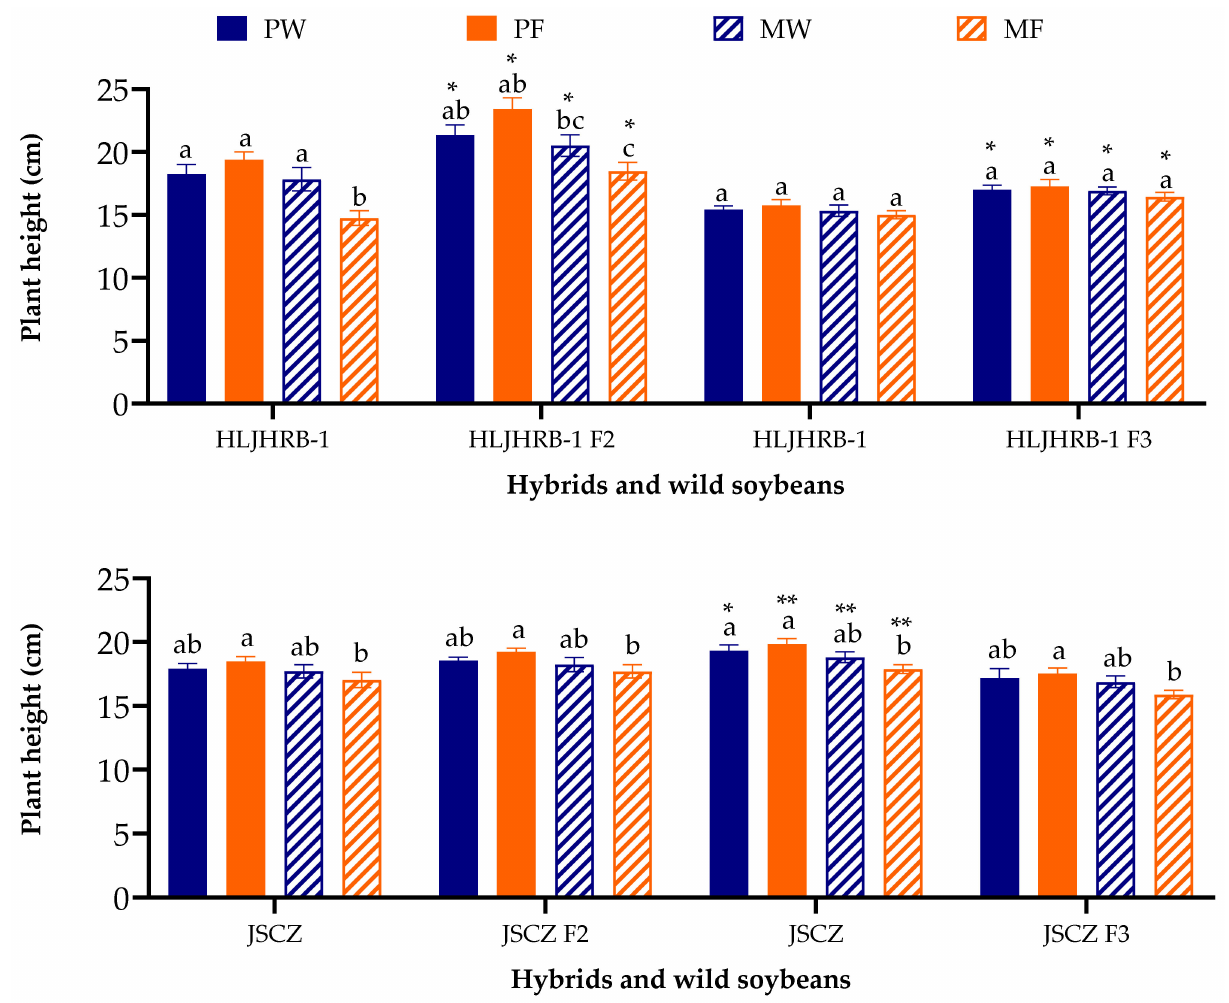
Figure 3. Plant height of hybrids and wild soybean under four planting conditions (the third trifo- liolate leaf stage). Note: * and ** indicate significant difference ( p < 0.05) and extremely significant difference ( p < 0.01) between hybrids and their wild soybeans. Different lowercase letters indicate significant difference ( p < 0.05) of hybrids or wild soybeans among four planting